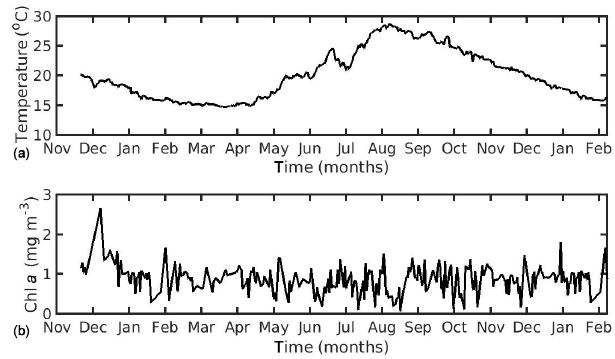
Figure 2. Environmental data used for the forcing of the dynamic energy budget model in the northern Ionian Sea simulation, showing (a) temperature and (b) chlorophyll a